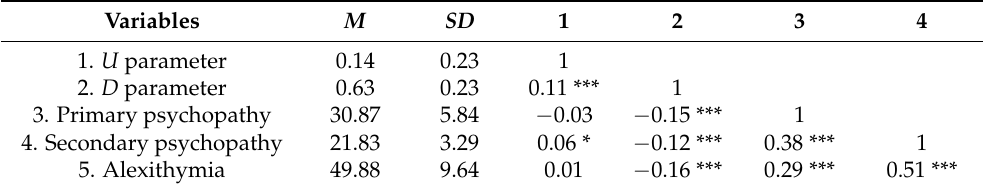
Table 1. Descriptive and Pearson correlations among the variables ( N =